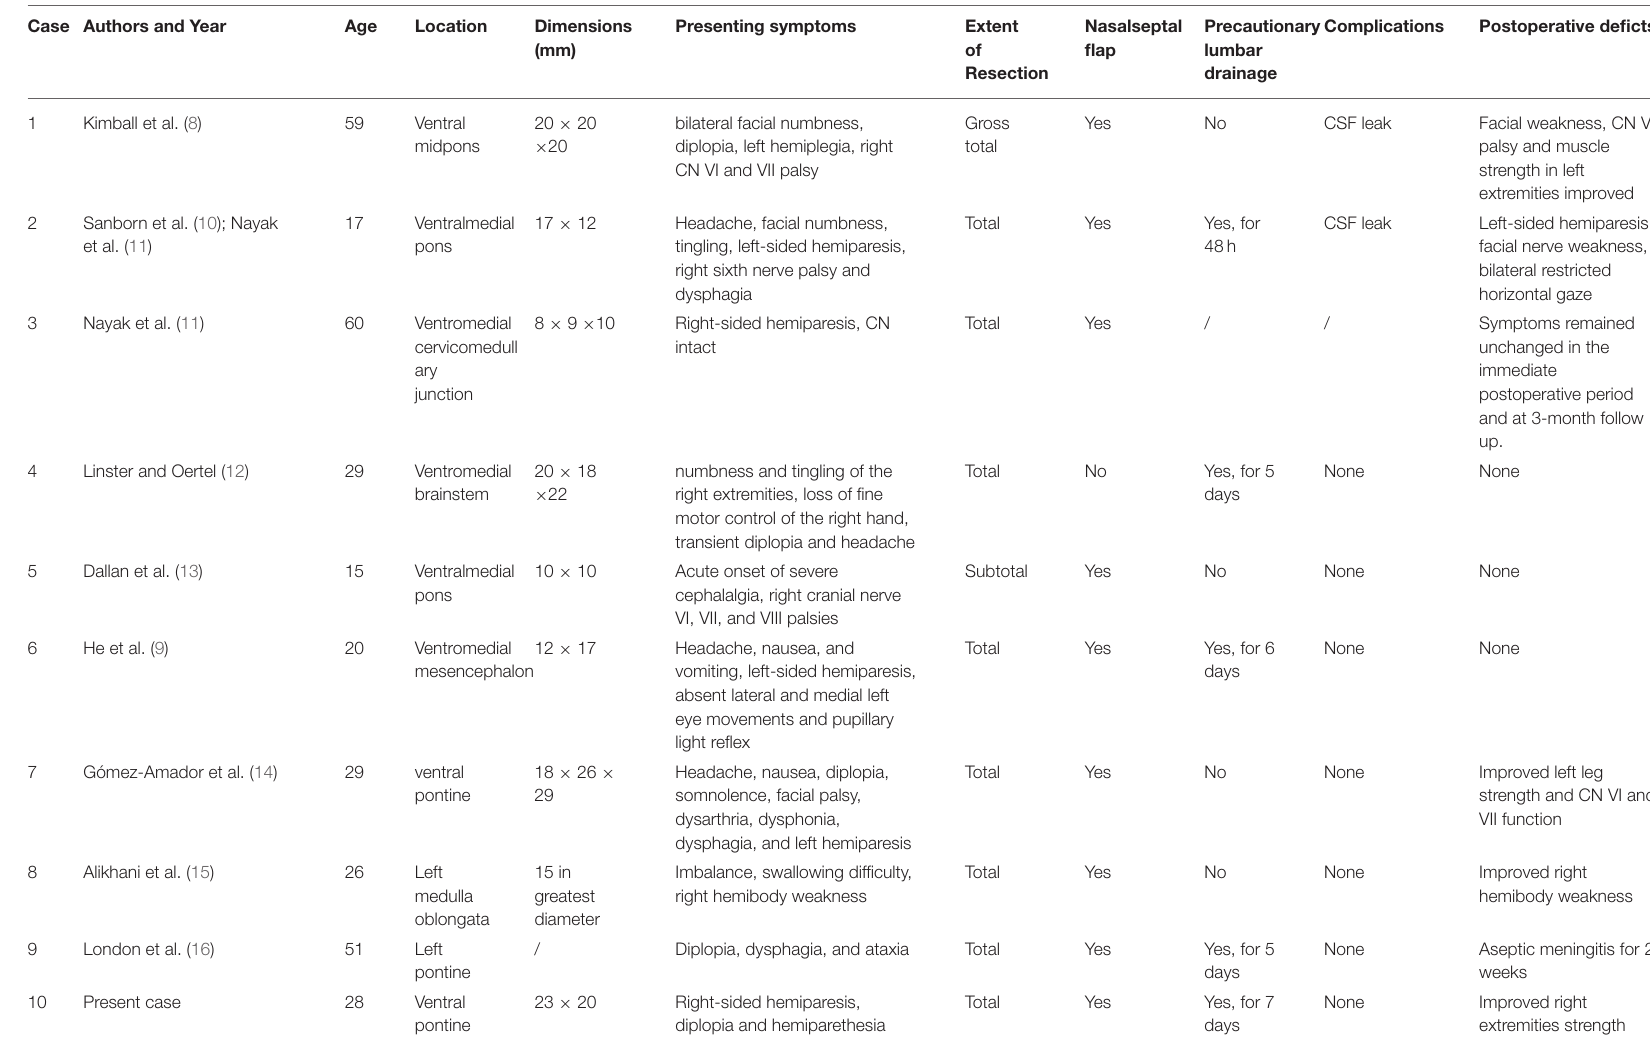
TABLE 1 | Comparison of reported cases of endoscopic endonasal transclival resection of